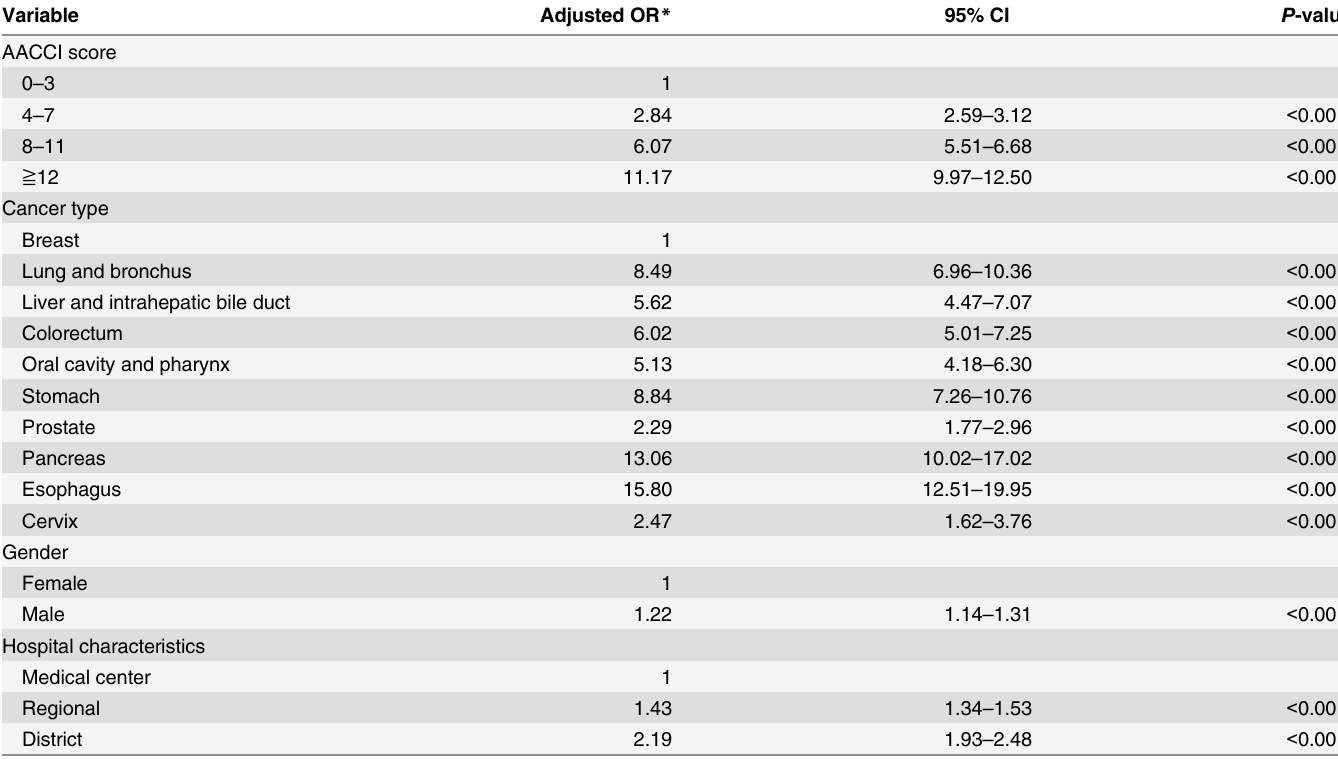
Table 6. Multivariate logistic regression